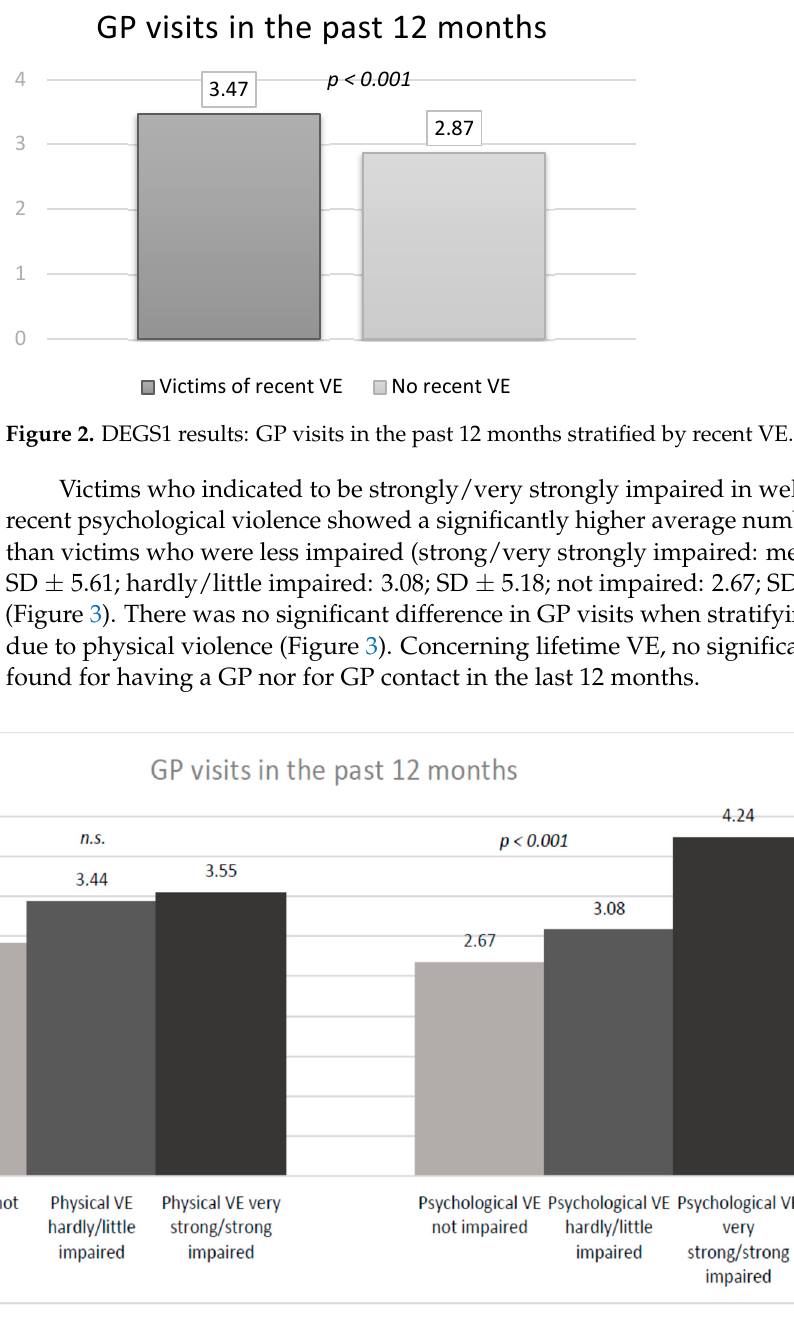
Figure 3. DEGS1 results: GP visits stratified by impairment due to recent physical/psychological VE. After specified assumptions (linearity, outliers, multicollinearity, normal distribution of errors, and homoscedasticity) had been tested and were not violated, and after exclud- 12 months), a multivariate regression model analyzed the association between recent VE and the number of GP contacts based on n = 5229 valid cases (Table 3). Model results (R 2 = 0.181) revealed that not only did gender, SES, subjective health status, physician- diagnosed depression in life, and presence of chronic diseases show significant influences, but also that victims of the preceding 12 months significantly indicated visiting their GP 0.33 times more often than